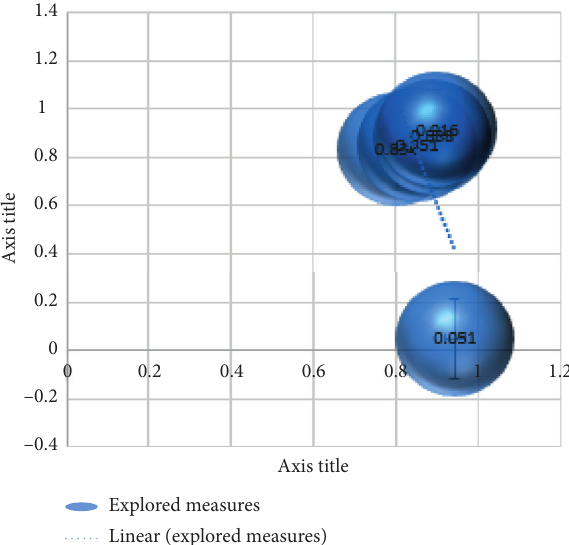
Figure 2: Graphical representation for the information of Table